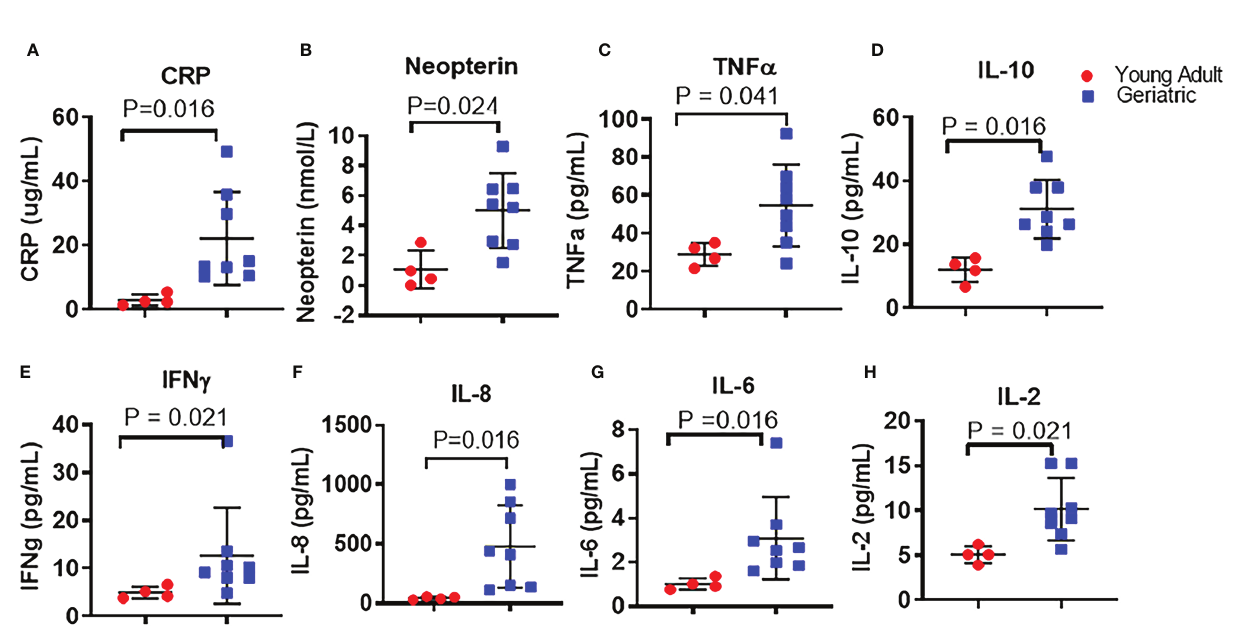
FIGURE 1 | Plasma in fl ammatory cytokines in young adult and geriatric Rhesus Macaques: ELISA kits were used to quantify levels of CRP (A) , and neopterin (B) in young adult and geriatric animals. Magpix multiplex analysis was used to quantify levels of TNF (C) , IL-10 (D) , IFN- g (E) , IL-8 (F) , IL-6 (G) , and IL-2 (H) in young adult and geriatric animals. Statistical analysis performed by Mann-Whitney U test with Benjamini-Hochberg correction for multiple comparisons to calculate the adjusted p-values (q value). Line and whiskers indicate the mean ± standard deviation. Q values are exact and a q < 0.05 was considered signi fi